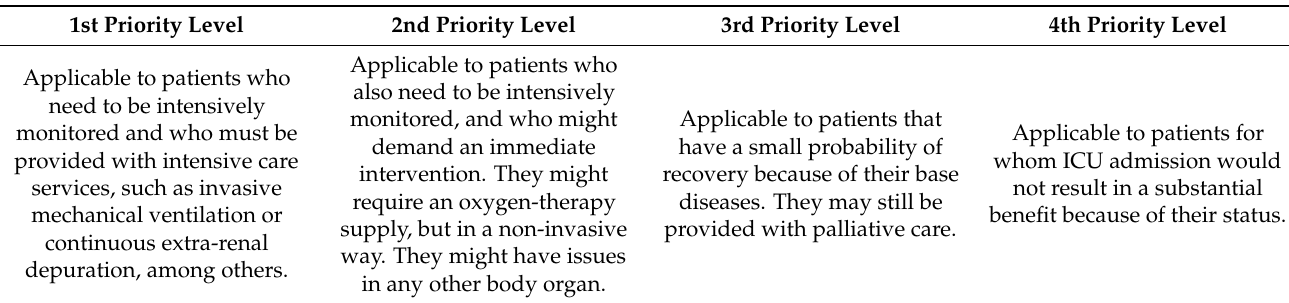
Table 2. Priority groups for ICU admittance. Elaborated from the work by Rubio et al.